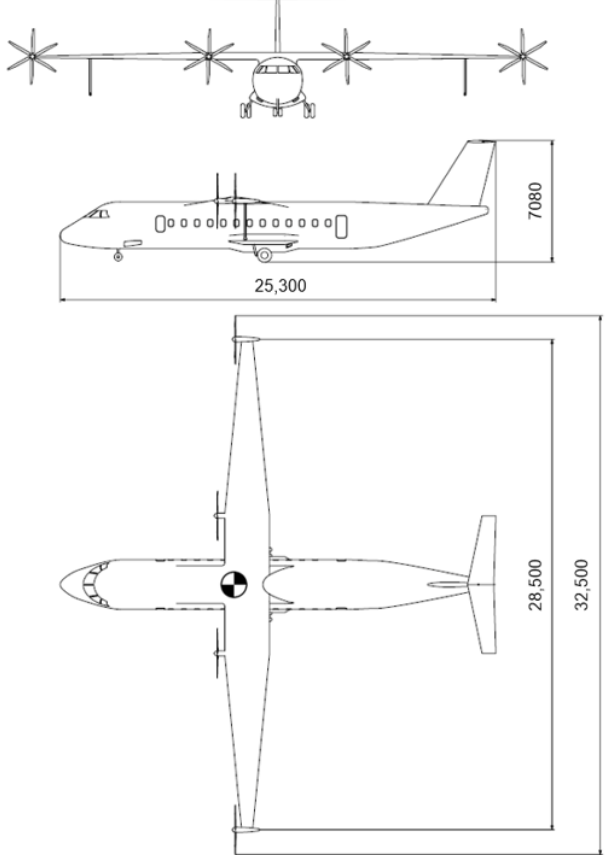
Figure 8. Three-side view drawing of HAIQU.